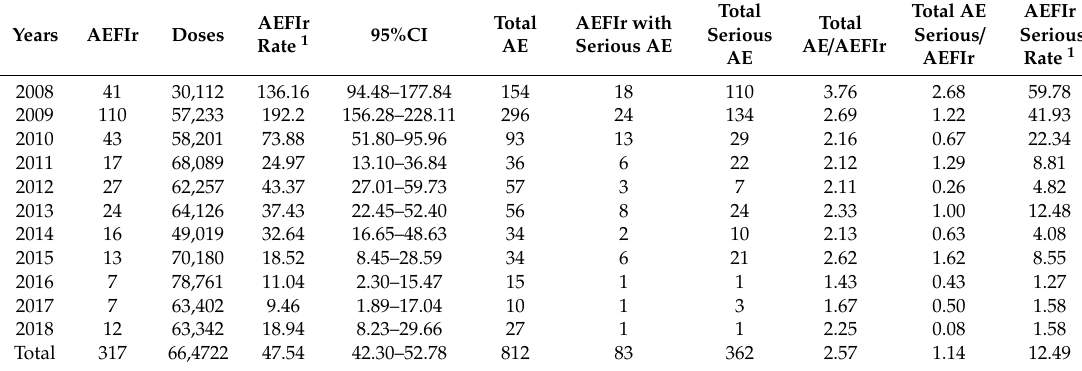
Table 1. Adverse events following immunization (AEFI) reporting rate following human papillomavirus (HPV) immunizations in the Valencian Community, Spain